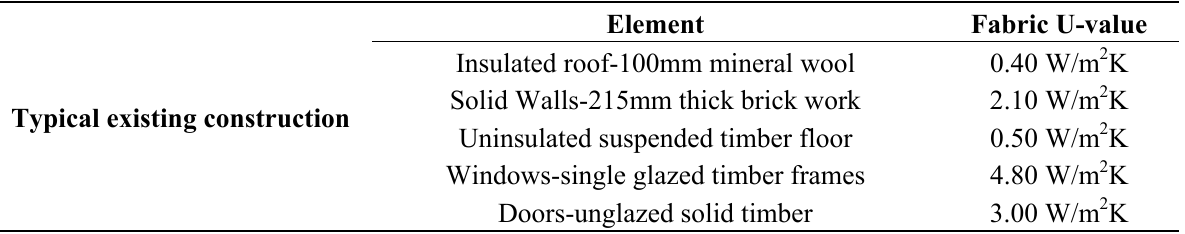
Table 1. Pre-refurbishment thermal features of a 19th century terraced house [9].